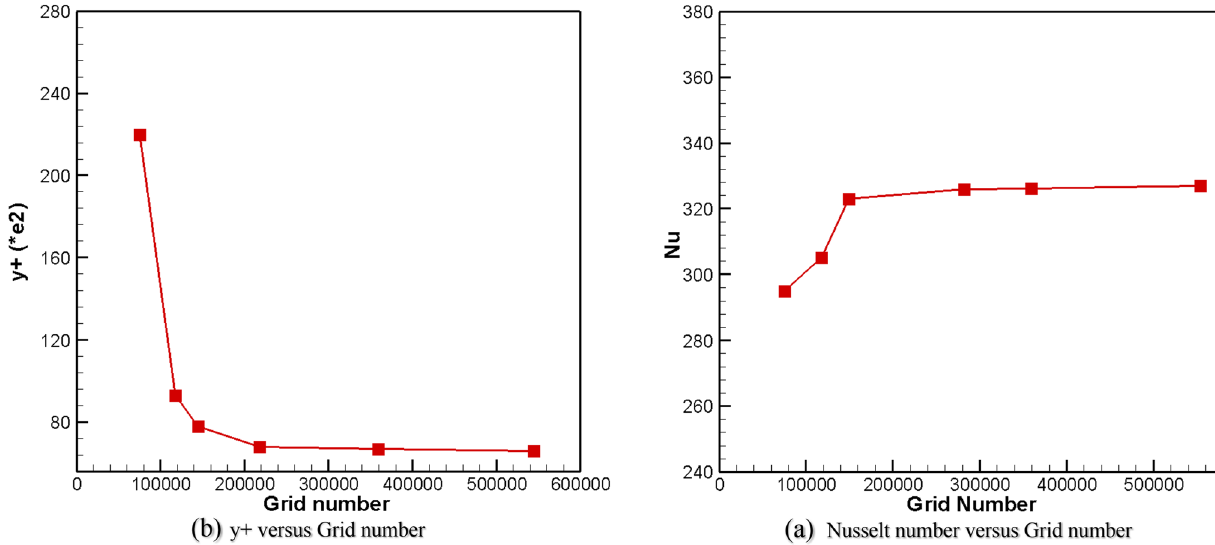
Fig. 4 Grid independence study at Re = 40,000, a Nusselt number versus Grid number. b y + versus Grid number